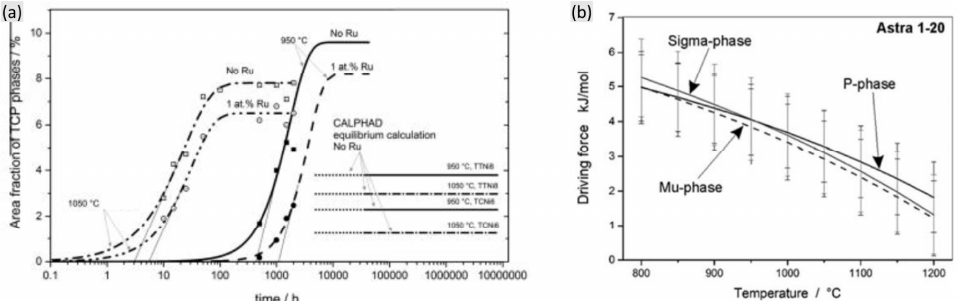
Figure 11. ( a ) Area fraction of TCP phases as a function of time for the alloys Astra 1–20 and Astra 1–21 at 950 °C and 1050 °C [54] and ( b ) the driving force for the precipitation of distinct phases within the alloy Astra 1–20 containing 2 at% Re with varying temperatures [52].